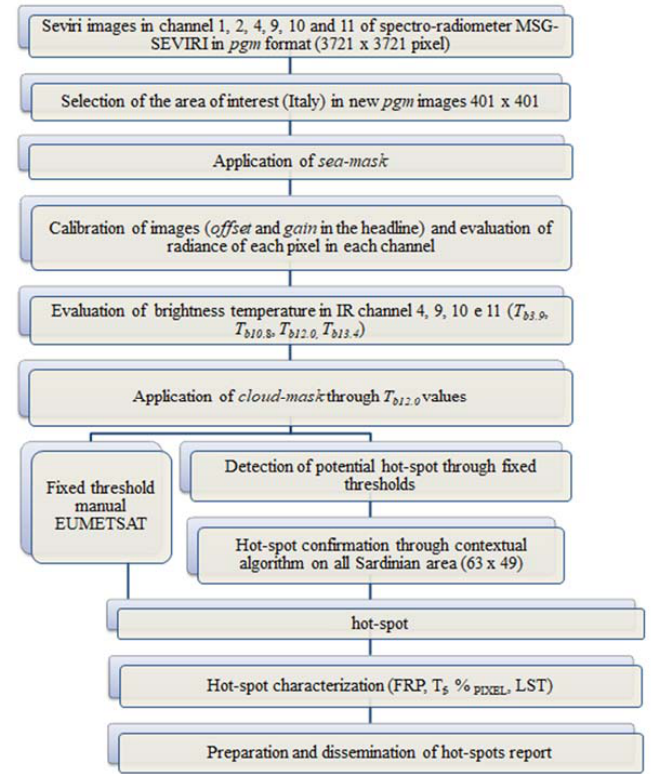
Figure 6. SFIDE algorithm prospect for nocturnal data analysis.